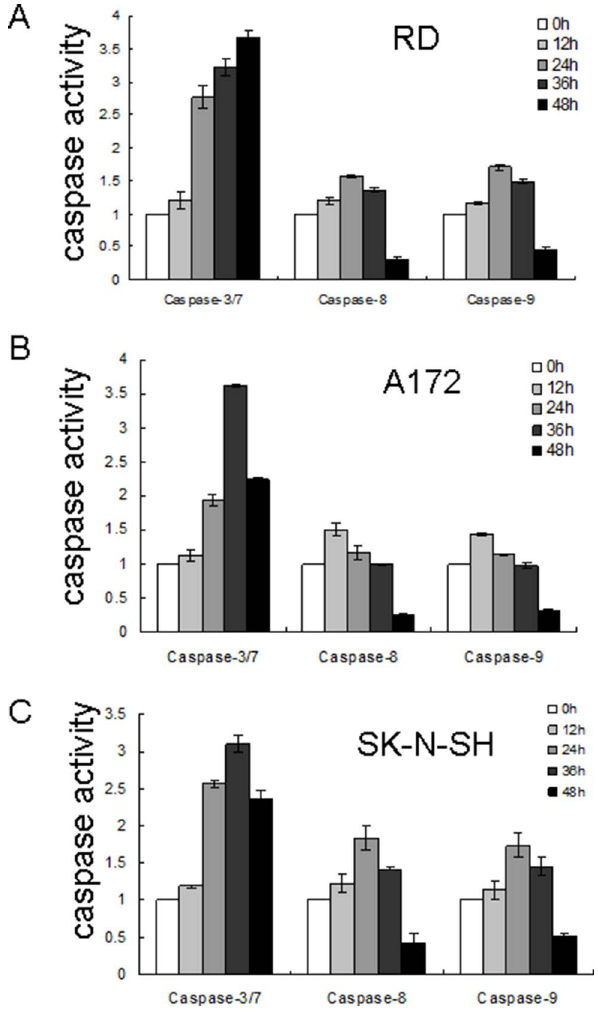
Figure 6. CA16 infection induces caspase activity in neural and non-neural cell lines. Neural and non-neural cell lines were infected with CA16 SHZH05 virus at the MOI of 0.2 and harvested at 12 h, 24 h, 36 h and 48 h. Activities of caspase 3/7, caspase 8 and caspase 9 were quantified and compared to the 0 h time point. (A) RD cells, (B) A172 cells, (C) SK-N-SH cells. Results are shown as the combined data set from three repeat experiments and presented as the mean 6 SD.